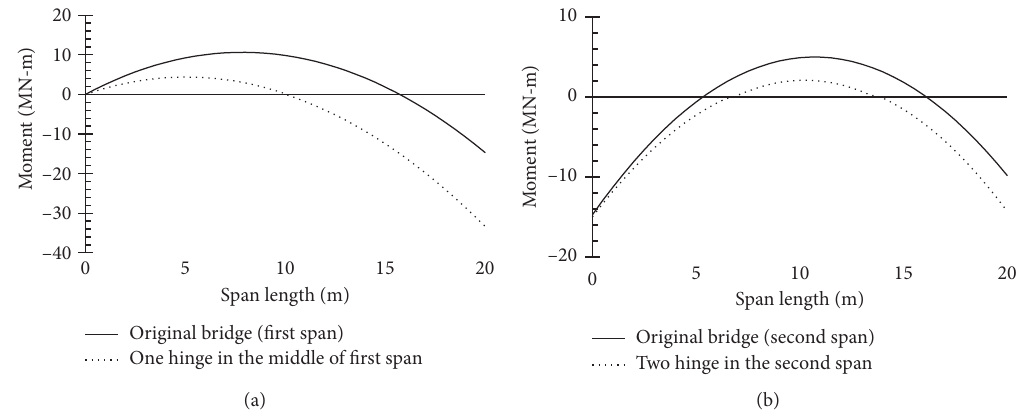
Figure 17: Diagram of the moment for (a) one hinge in the first span length and (b) two hinges in the second span length.